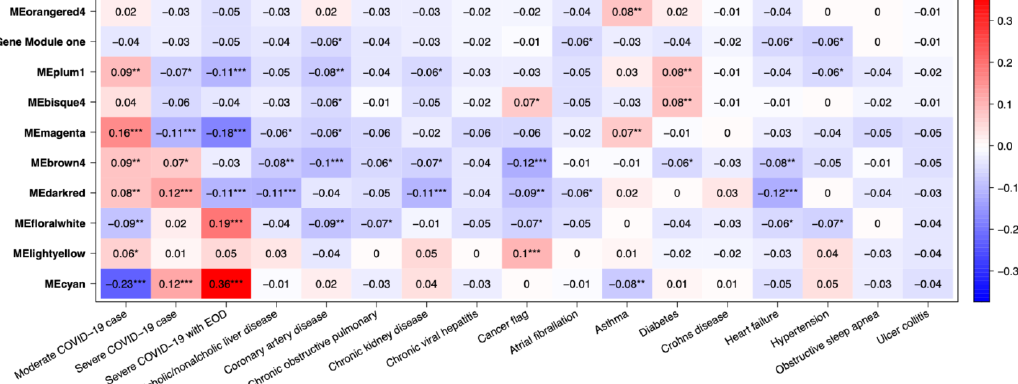
Figure 13. Dot plot for top 20 enriched pathways based for gene module, MEcyan based on KEGG.